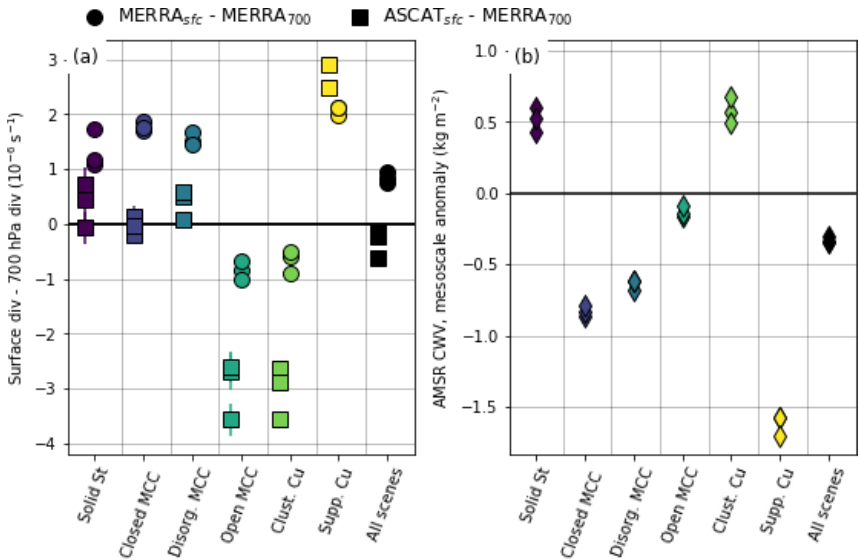
Figure 9. (a) Surface divergence anomaly from 700hPa (circles are based on MERRA-2 surface winds; squares are based on ASCAT surface winds). (b) AMSR-2 column water vapor mesoscale anomaly.